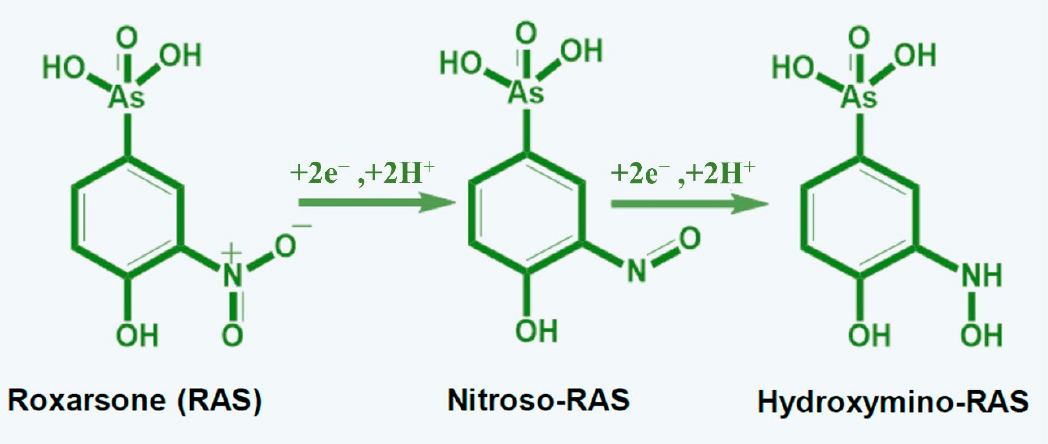
Figure 9. An illustration of electrocatalytic reaction mechanism of toxic roxarsone on the WS 2 -based SPE electrode sensor. Reprinted with permission from [167]. Copyright 2019 Elsevier.